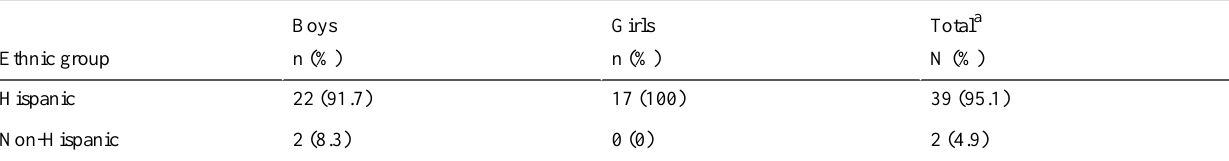
Table 1. Classification of study participants by ethnicity.